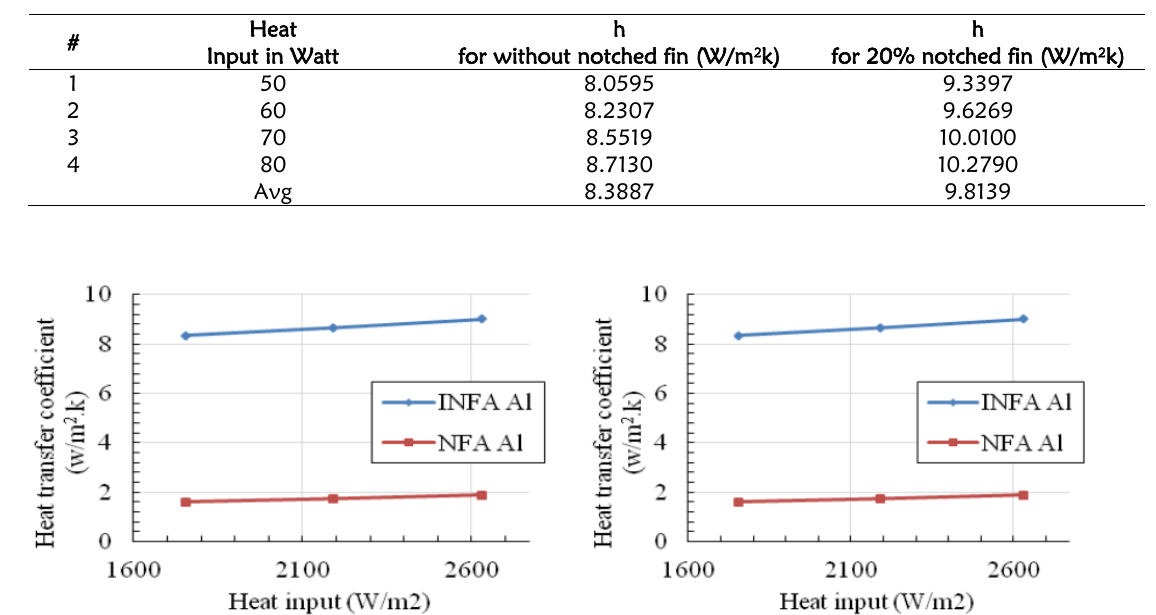
Figure 6: Heat Transfer Coefficient for Fin Arrays